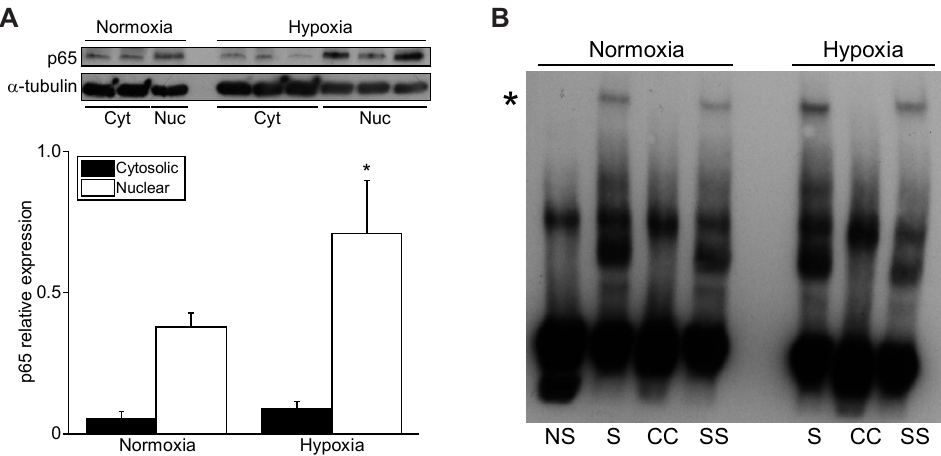
Figure 3. Hypoxia increases nuclear NF-κB p65 activity. ( A ) Western blot analysis of cytosolic and nuclear fractions for NF-κB p65 subunit in cardiac myocytes during normoxia or hypoxia. p65 expression is normalized to α-tubulin. * p < 0.05 versus nuclear normoxia sample. ( B ) Electromobility shift analysis of nuclear extracts for NF-κB p65 subunit binding derived from cardiac myocytes under normoxic and hypoxic conditions. Asterisk (*) denotes shifted protein–oligonucleotide complex, which is depleted following p65 antibody super-shift (SS). NS, non-shifted control lacking cell lysate; S, shifted sample containing p65-transfected cell lysate; CC, shift using cold competition (200x unlabeled oligonucleotides).